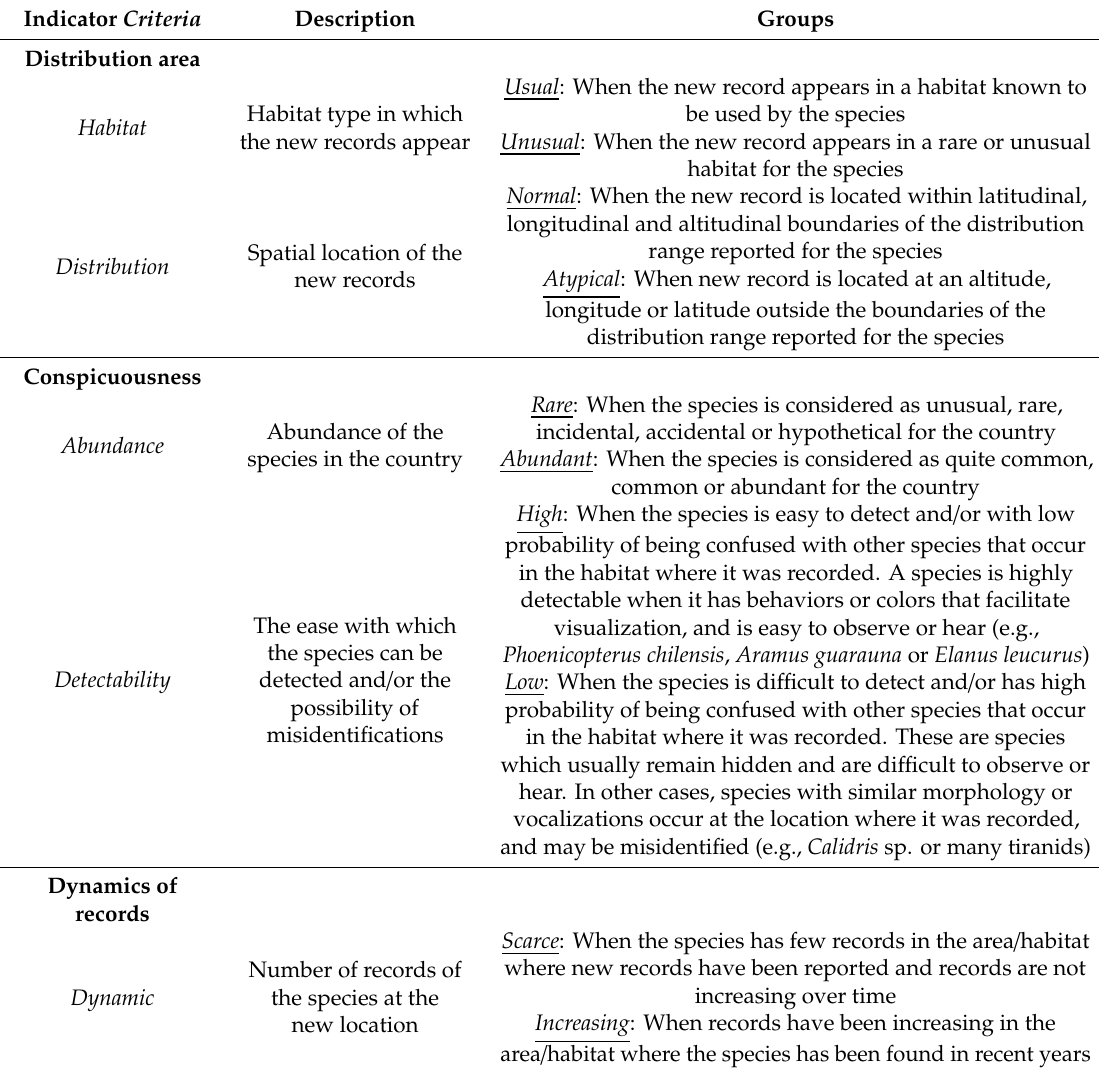
Table 1. Description of the indicators and criteria used for the classification of the new records of birds reported in the Ecuadorian part of the Tumbesian region in the last two